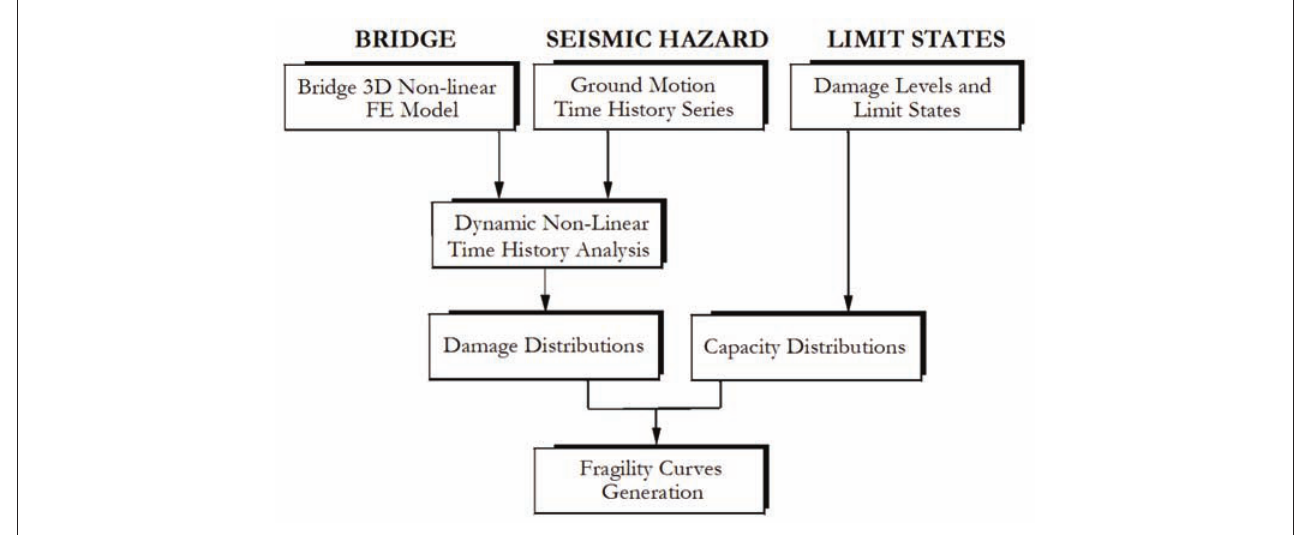
Figure 5 – Analytical fragility curve methodology to the Chemin des Dalles